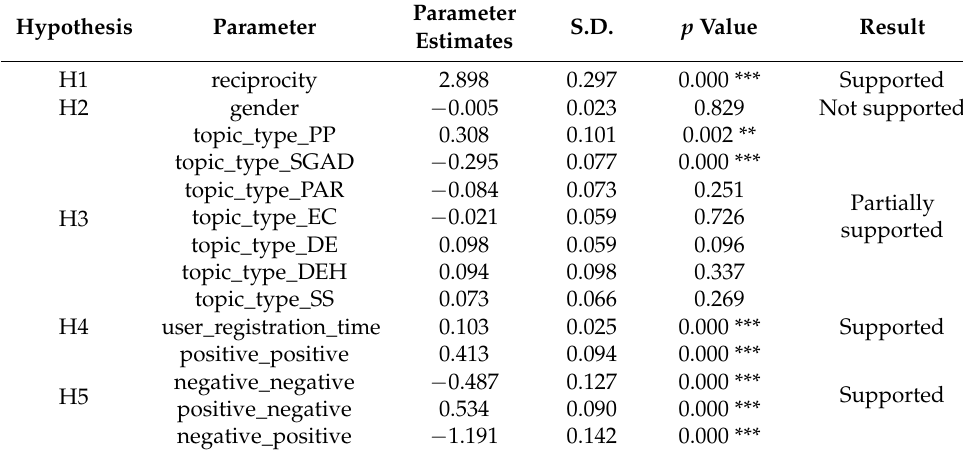
Table 3. The exponential stochastic graph model test